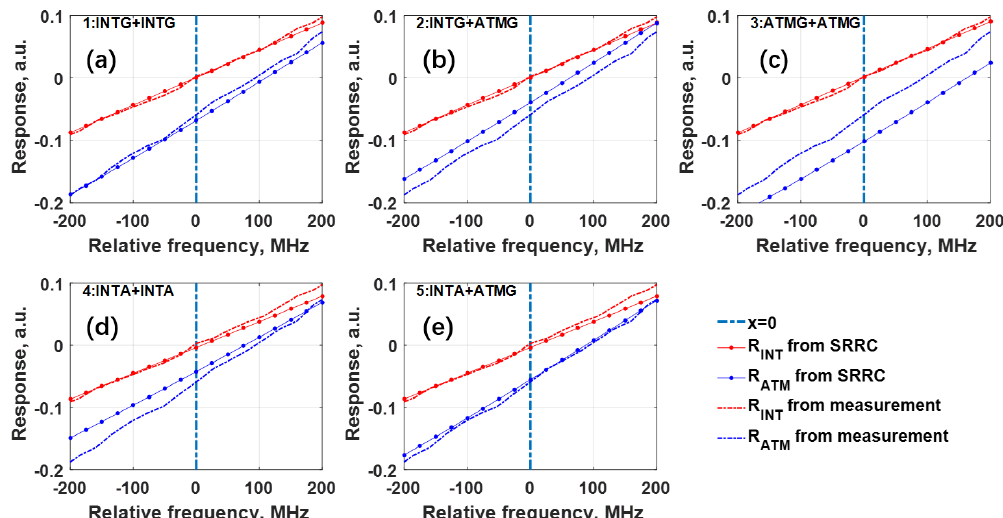
Figure 6. The response functions of internal reference and eighth atmospheric altitude bin from MRRC (red and blue dashed lines, respec- tively, same on every plot) and different SRRCs using different combinations of FPI transmission parameters (red and blue dotted lines, respectively) a listed in Table 4.